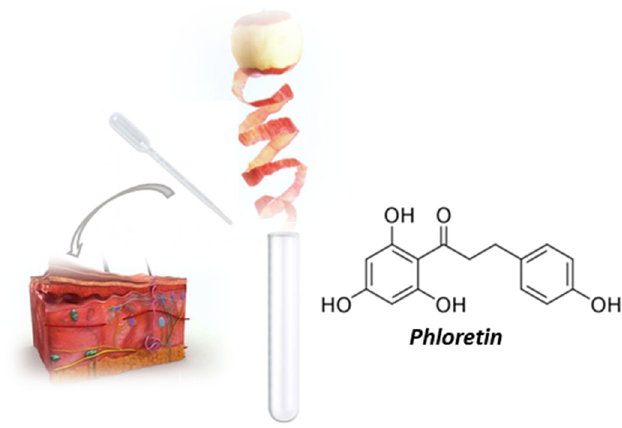
Figure 1. Phloretin: structure and source.